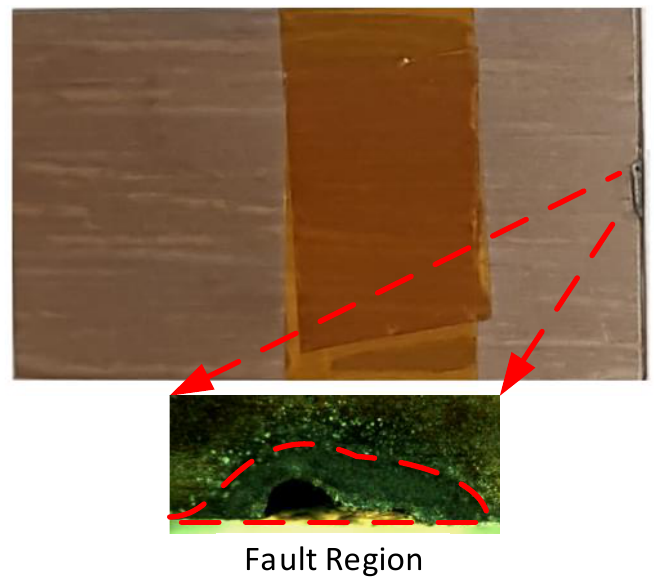
Figure 1. Experimental sample with the magnified image of the fault region.